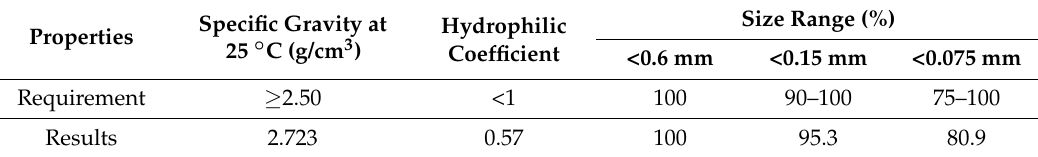
Table 4. The physical properties of mineral